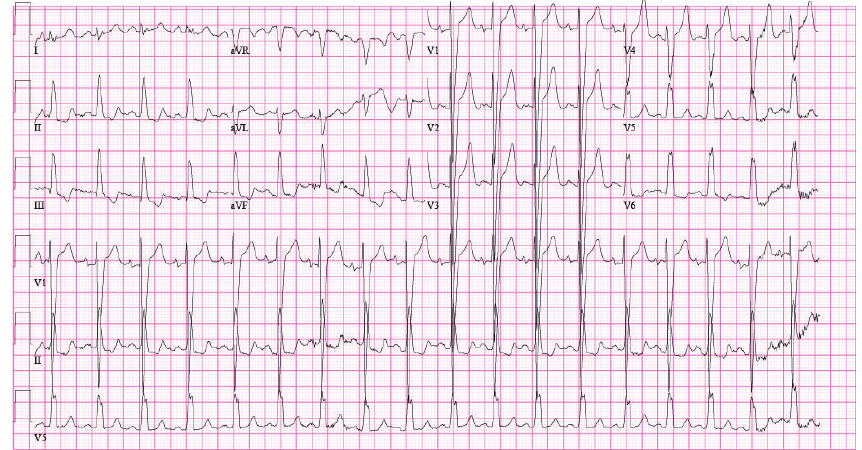
Figure 1: EKG tracing at presentation showing left bundle branch block with heart rate of 108/minute, PR interval of 148 milliseconds, QRS duration of 124 milliseconds, and QTc of 413 milliseconds.